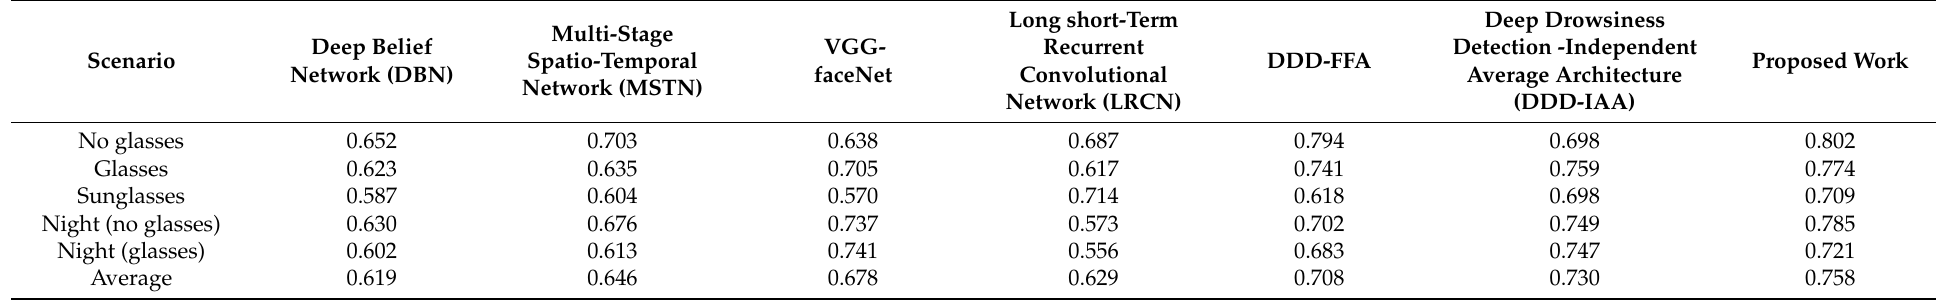
Table 4. The average accuracy of the drowsiness detection methods under different conditions was compared with the evaluation dataset of the NTHU-DDD dataset.